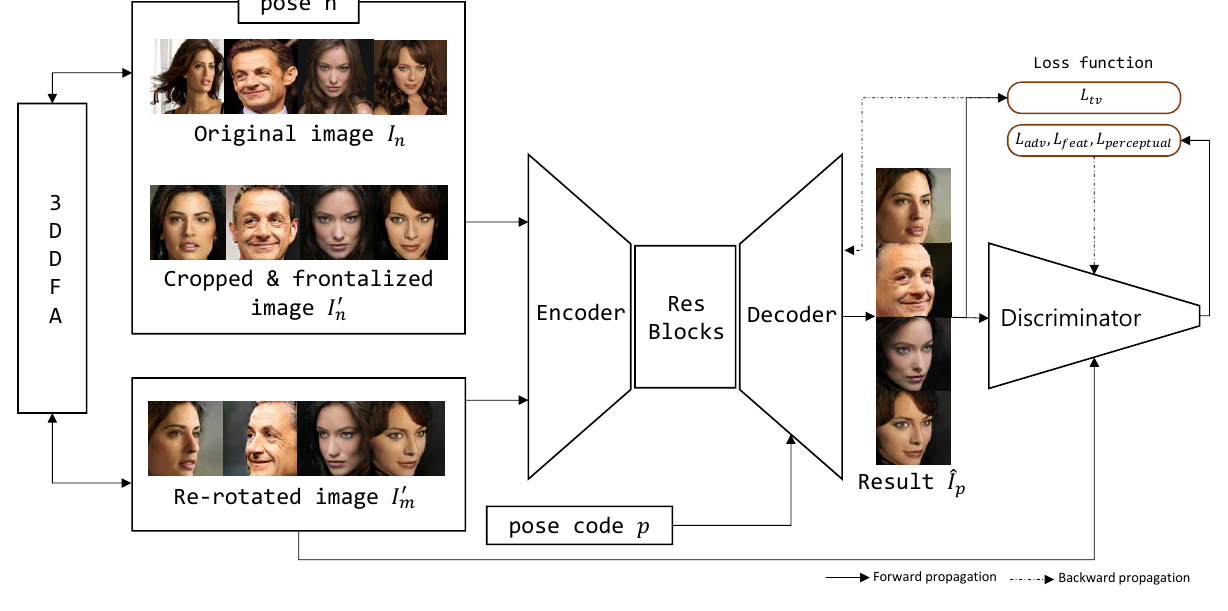
Figure 2. The process of our